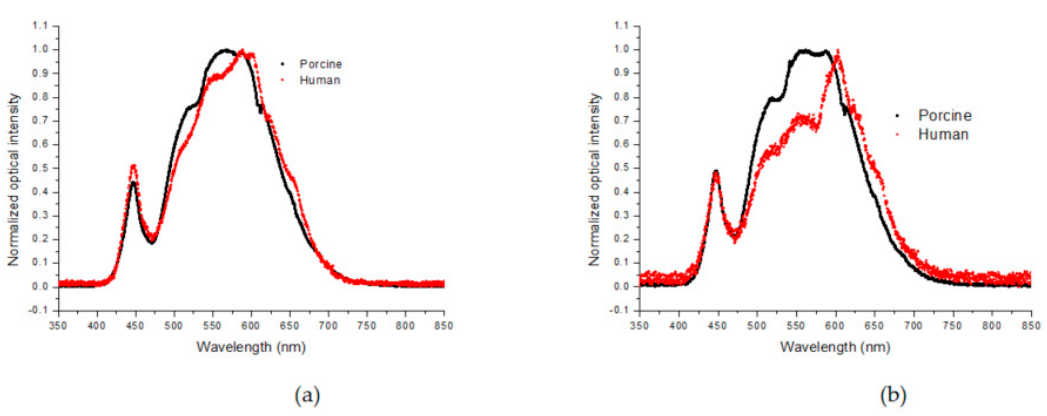
Figure 7. Comparison of frozen and unfrozen porcine/human tissues (black/red, respectively). ( a ) Frozen porcine/human tissue; ( b ) Unfrozen porcine/human tissue (black/red, respectively).